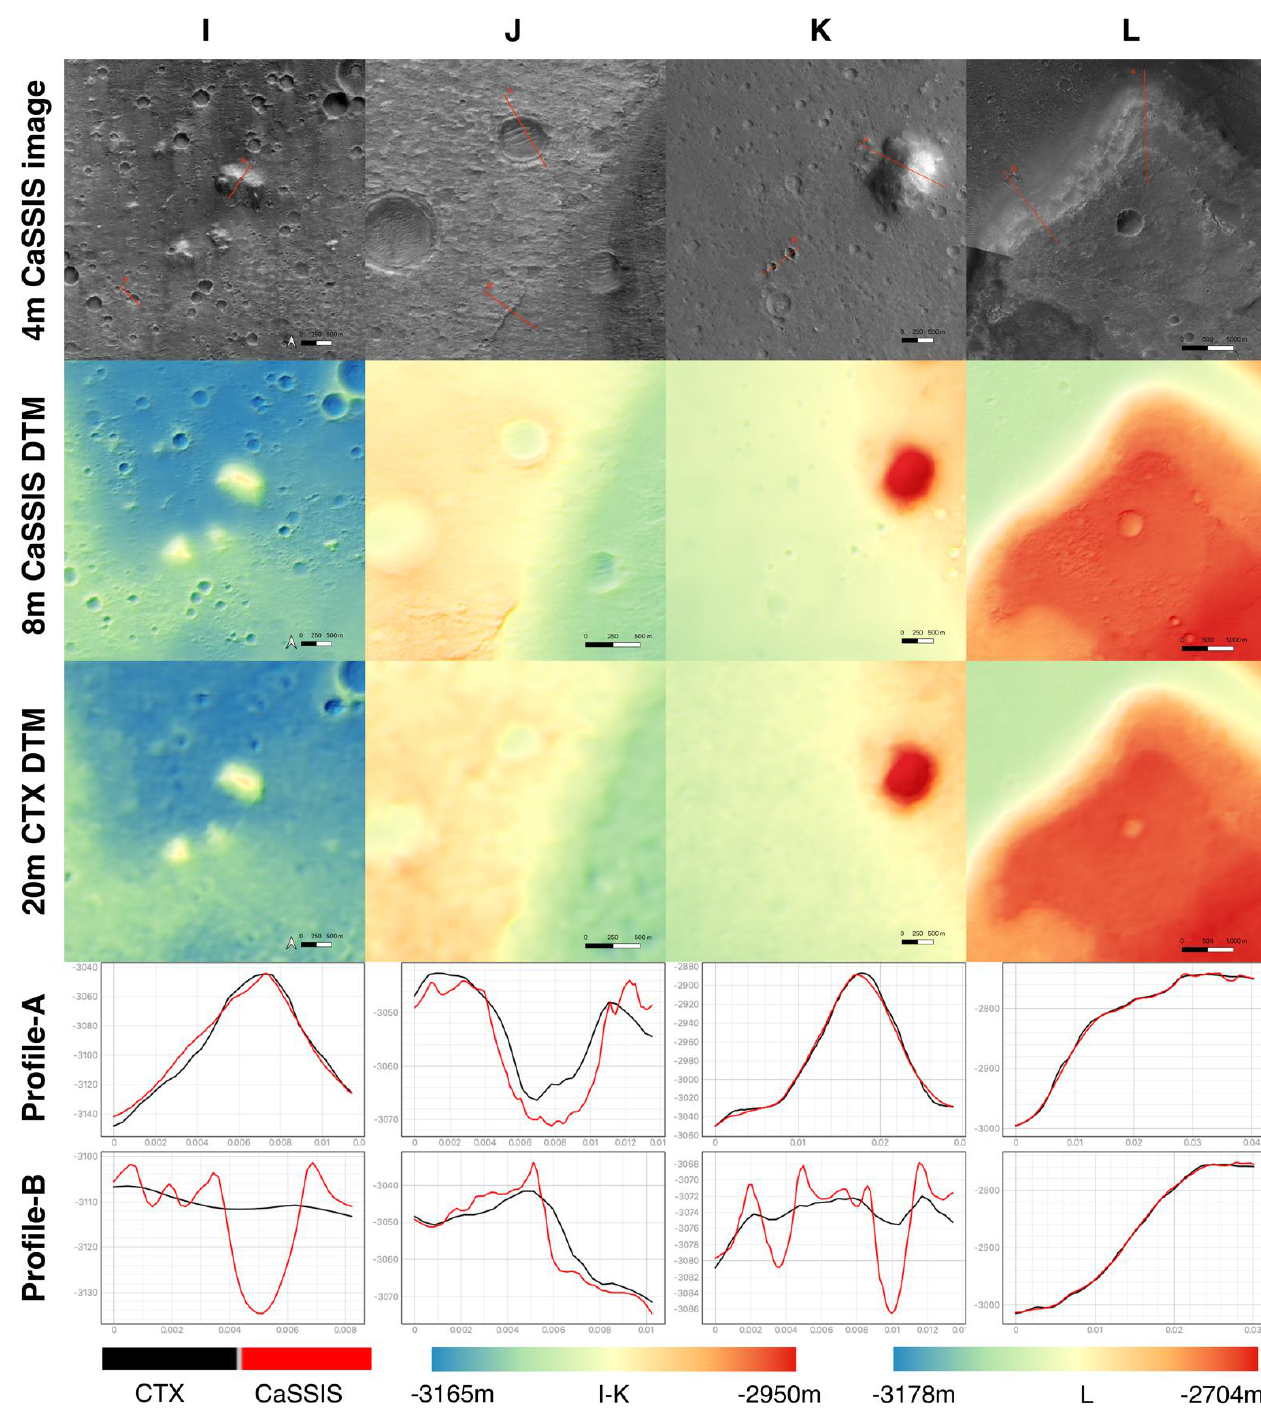
Figure 8. Zoom-in views of the 4 m/pixel CaSSIS image, 8 m/pixel MADNet CaSSIS DTM, 20 m/pixel CTX DTM, and measured profiles (location shown on the CaSSIS images; black: CTX, red: CaSSIS), for area ( I – L ), where there are no HiRISE stereo (location shown in Figure 5). All DTMs are colour hillshaded. To look into details—please refer to the full-resolution figures provided in Supplementary Materials.